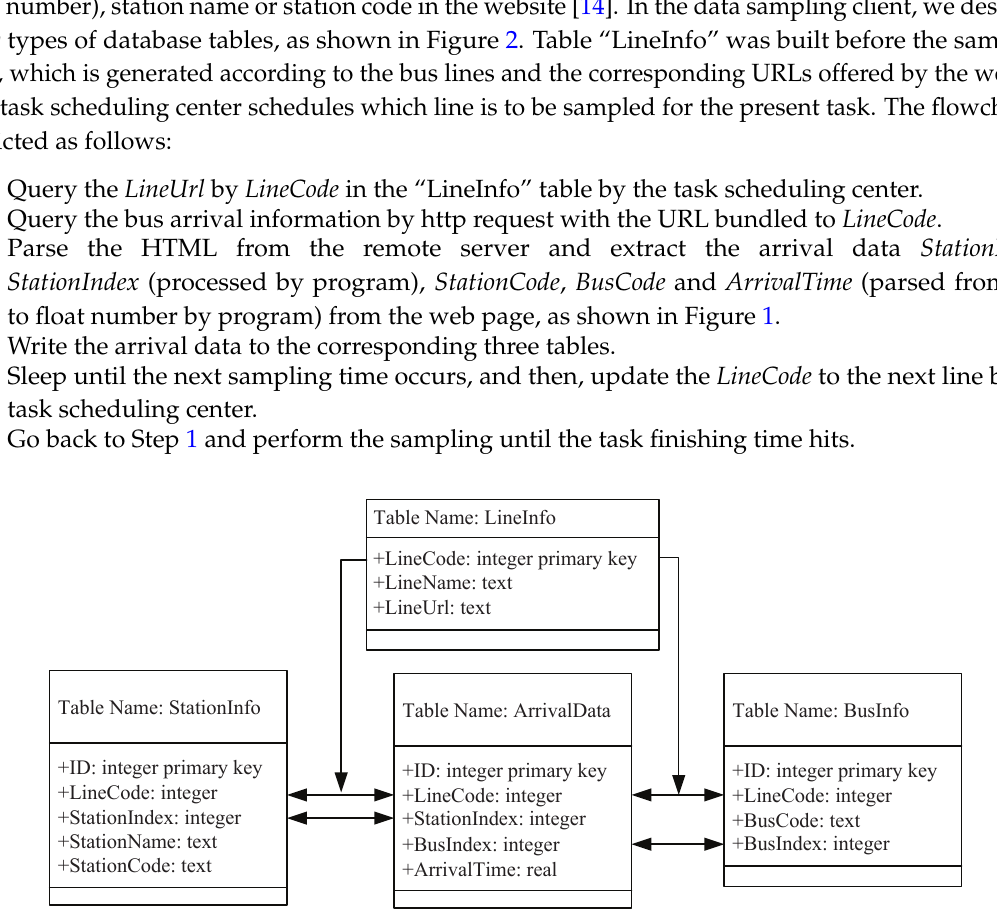
Figure 2. Database design for the urban bus arrival information.